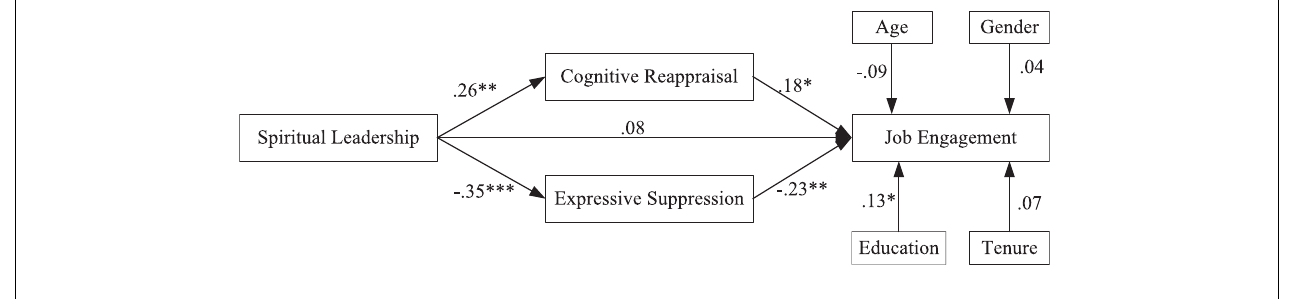
FIGURE 2 | Results of path analysis. ∗ p < 0.05; ∗∗ p < 0.01; ∗∗∗ p <